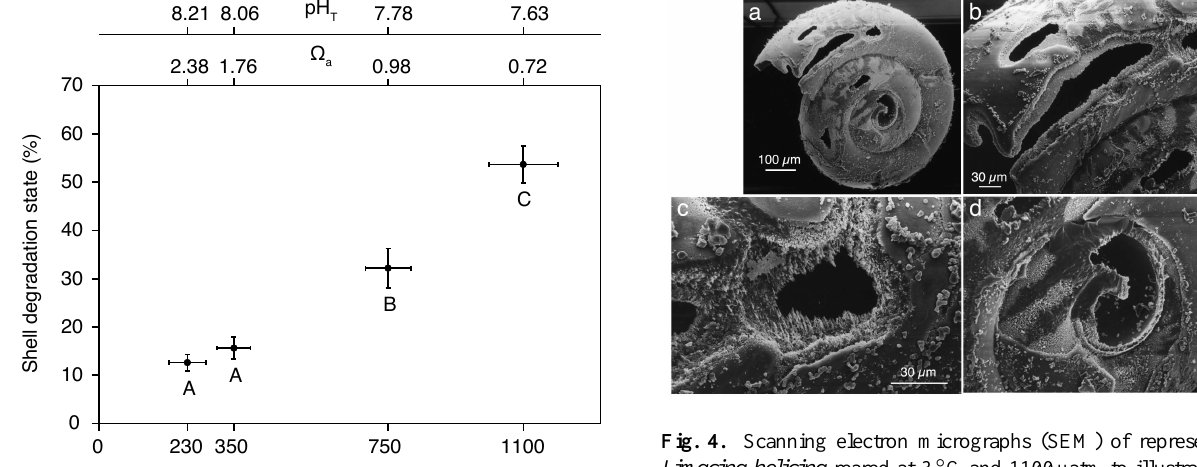
Fig. 4. Scanning electron micrographs (SEM) of representative Limacina helicina reared at 3 ◦ C and 1100µatm to illustrate shell degradation state specifically with respect to category IV and V. Magnification and scale bars are shown. The individual shown is the same as the one shown in Table 1 for category V with ≥ 5